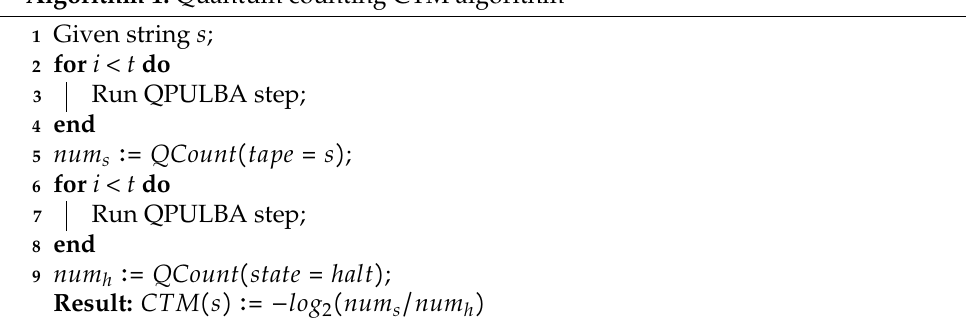
Algorithm 1: Quantum counting CTM